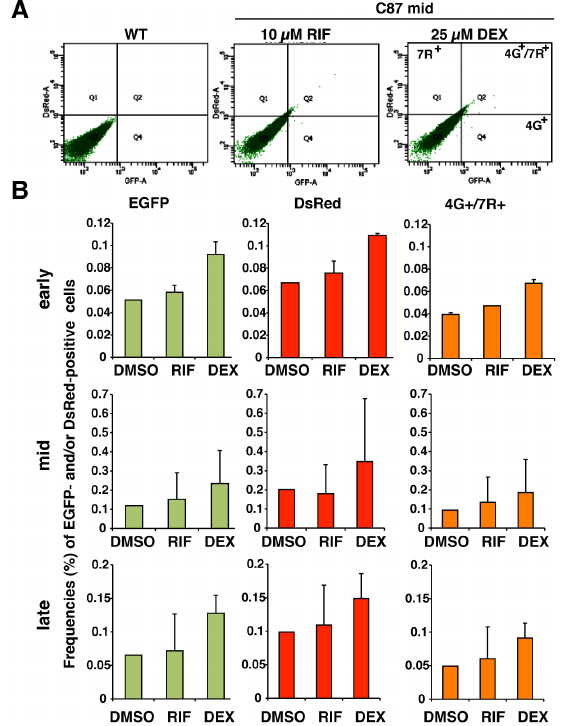
Figure 3. CYP3A inducers markedly increase the number of EGFP-positive transgenic HepG2 cells. (A) FACS analyses showing